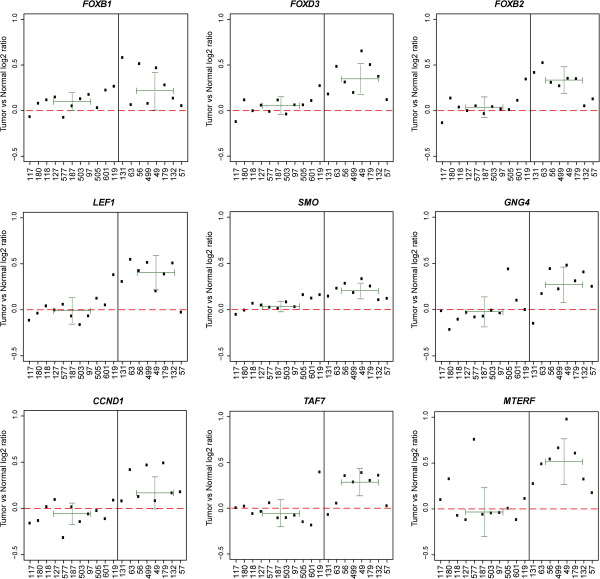
Scatter plots for nine unique genes with BRAF mutation-specific promoter methylation causing pathway enrichment. The y axis represents the tumor/normal log2 ratio for the median probe per region. Sample IDs are given below the x axis with BRAF wildtypes on the left of the black line and BRAF mutants on the right. Median log2 ratios and standard deviations (dotted lines) for the BRAF wildtype and BRAF mutant groups are given in dark green.